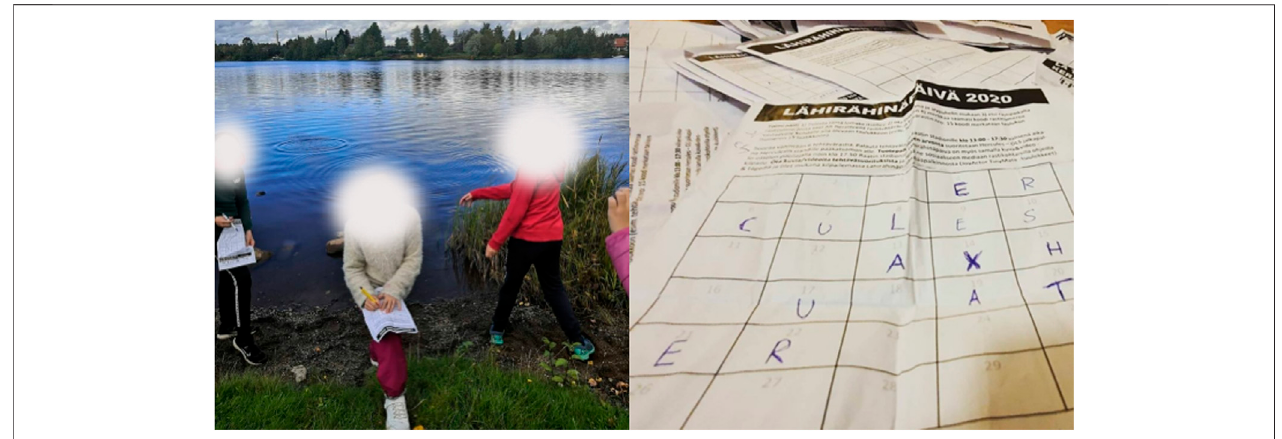
FIGURE 6 | Participants fi lling in the task sheet (left) and returned task sheet (right). Checkpoint visits and number of application downloads.